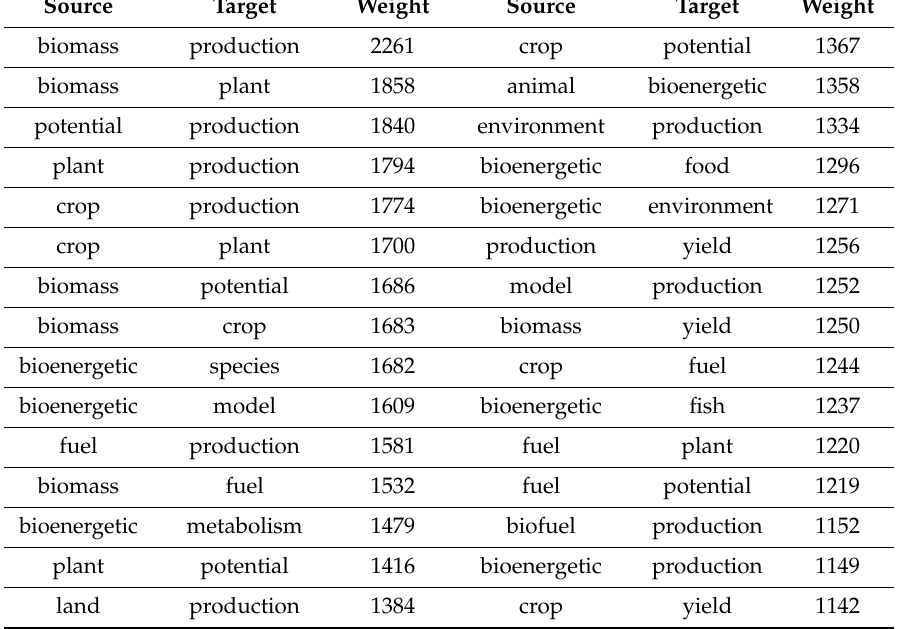
Table 8. Couples of terms with the highest number of relationships during the period 2000–2019, values of the occurrences.